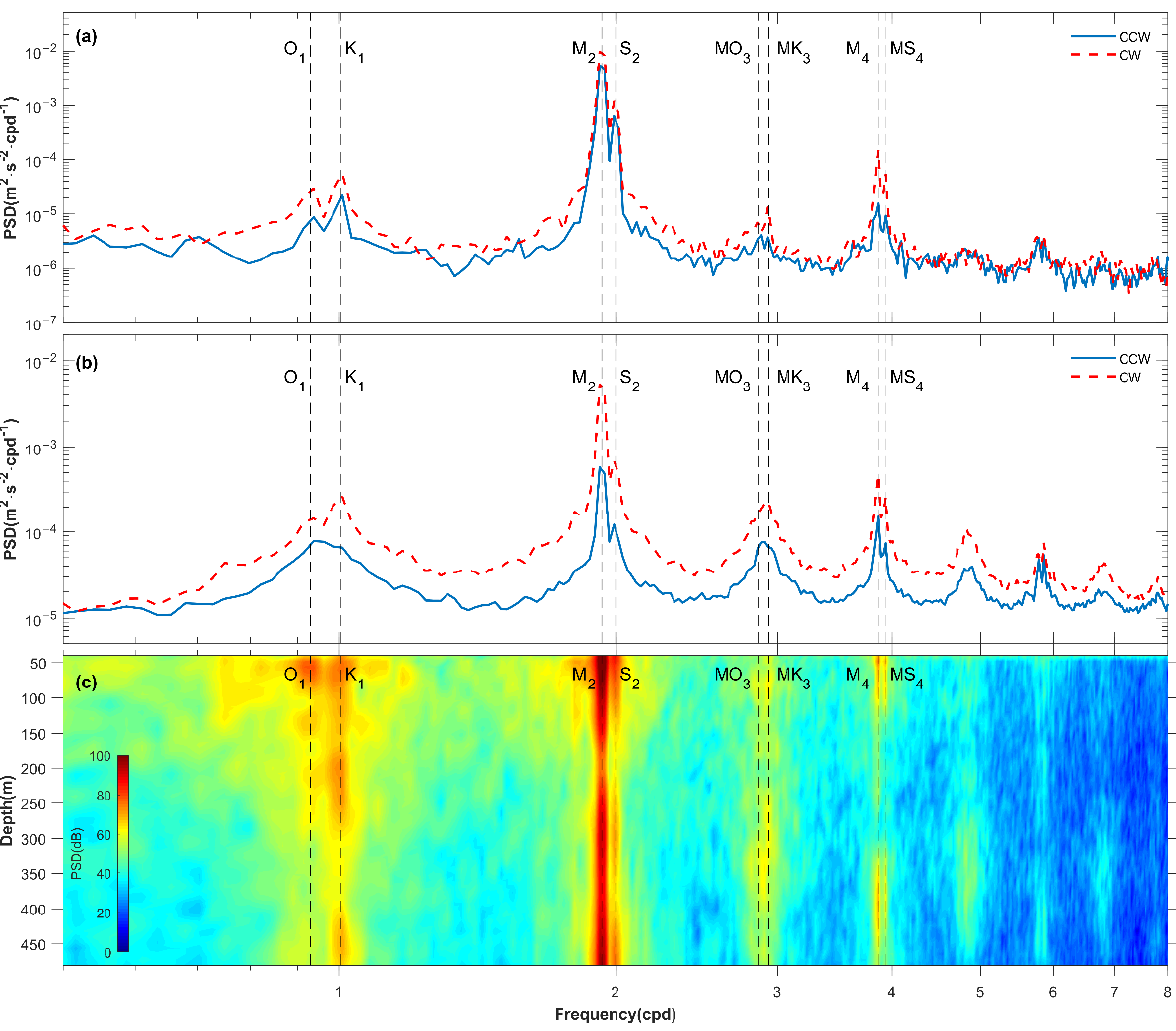
Figure 2. Variance-conserving plot of ( a ) rotary spectra of the barotropic currents, ( b ) depth-mean rotary spectra of the baroclinic currents, and ( c ) depth-frequency plot of the clockwise rotary spectra of the baroclinic currents. The blue solid and red dashed lines denote the counterclockwise (CCW) and clockwise (CW) components of the rotary spectra, respectively.